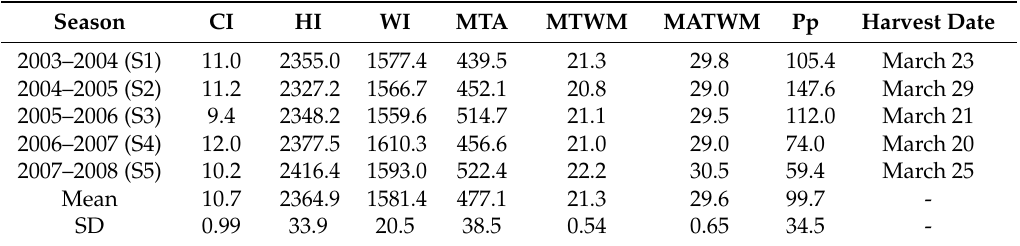
Table 1. Information about bioclimatic indices such as cool night index (CI), Huglin’s